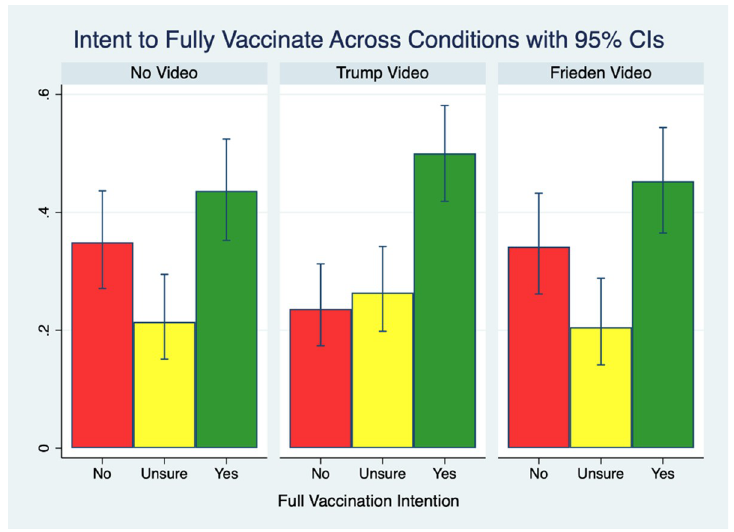
Fig 1. Vaccination intention by experimental condition, with 95% confidence intervals.